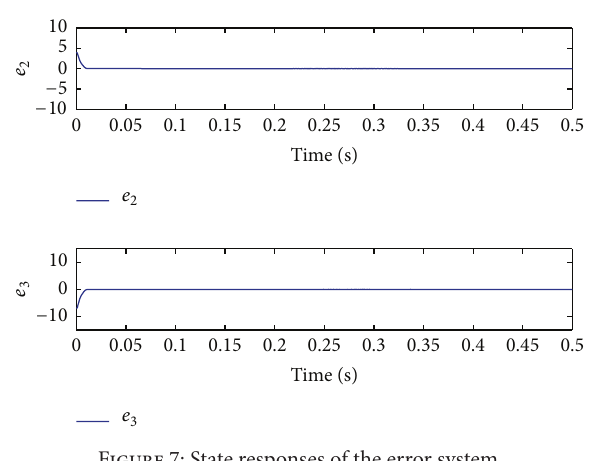
Figure 7: State responses of the error